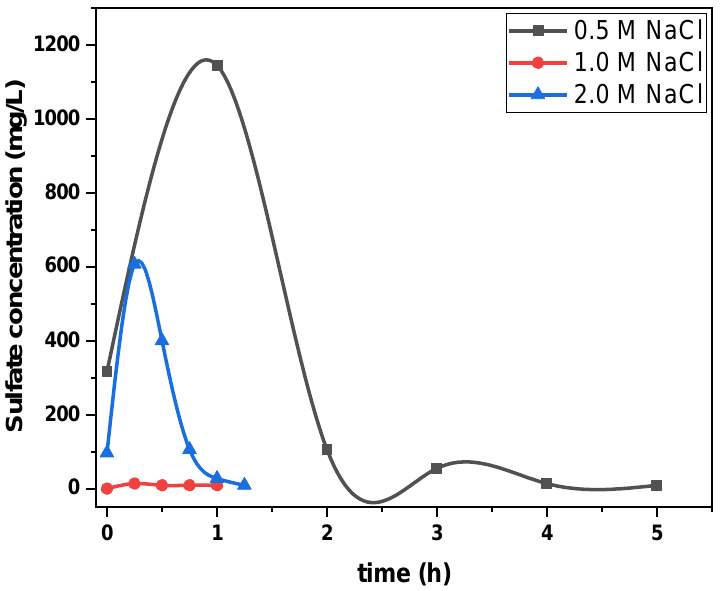
Figure 6 . Desorption test to evaluate regeneration of the composite material with 0.5 M NaCl colu- tion and subsequent use of 1.0 M and 2.0 M NaCl solution to attain an in-depth desorption profile for sulfate